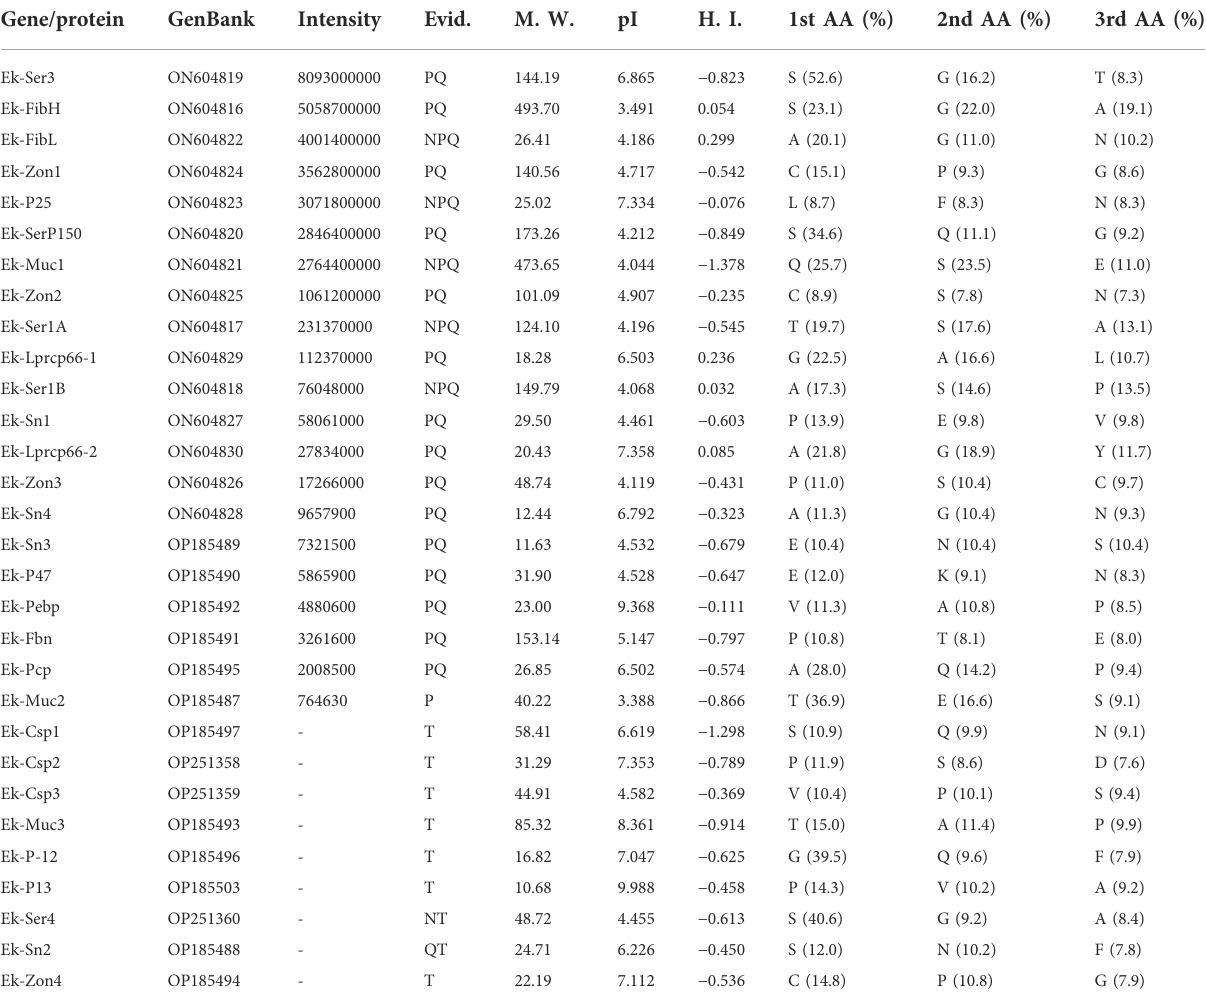
TABLE 1 Major silk proteins in E. kuehniella cocoons. GenBank – GenBank accession numbers; Intensity – MaxQuant peptide intensity; M.W. – molecularweight(kDa);pI – isoelectricpoint;H.I. – hydropathyindex(GRAVY);1 st /2 nd /3 rd AA(%) – proportionofthethreemostfrequent amino acids; Evid. – data to detect/infer proteins, where N, P, Q, and T represent northern blotting, proteome, qPCR, and transcriptome.